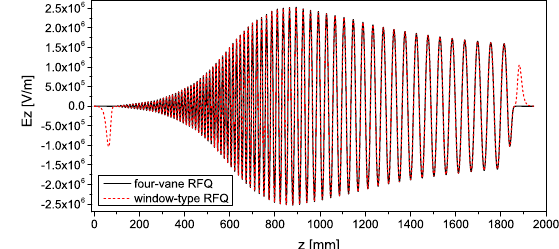
RFQs.FIG. 12. The electric field along the RFQ before and after